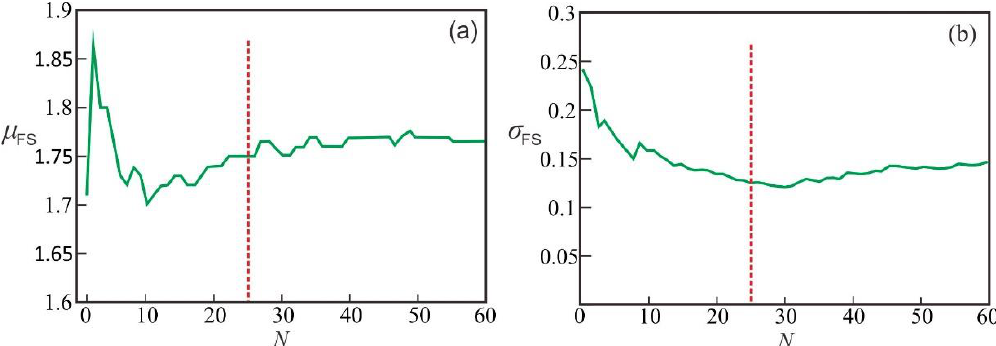
Figure 5. Influence of the number of realizations on µ Fs and σ Fs (( a )—the fluctuation of µ Fs with N increases; ( b )—the fluctuation of σ Fs with N increases).